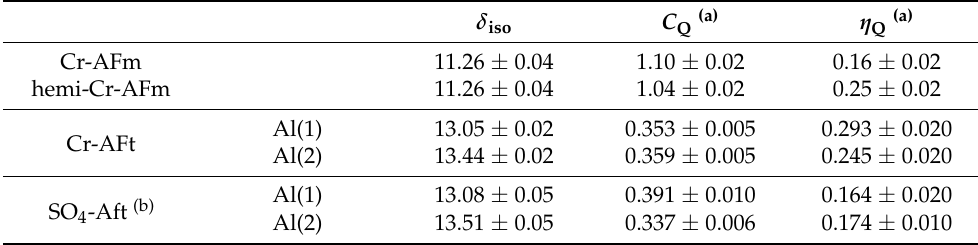
Table 1. 27 Al isotropic chemical shifts ( δ iso ) and quadrupolar coupling parameters ( C Q , η Q ) for the chromate AFm and AFt phases determined in this work.